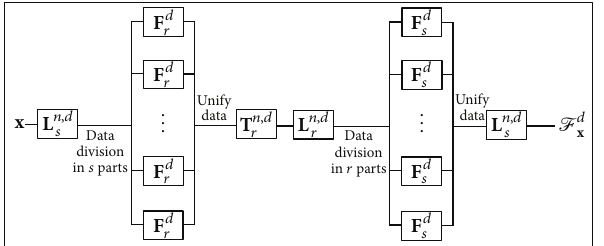
Figure 1: Parallel model of vector-valued DFT for x ∈ 𝑙 2 ( Z 𝑛 , C 𝑑 ) , 𝑛 = 𝑟𝑠 , using a matrix representation.